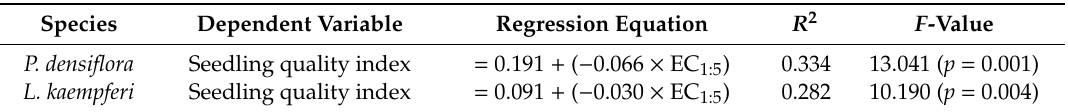
Table 3. Stepwise multiple regression analysis of seedling quality index (SQI) and selected soil parameters (AP, Ca 2 + , Mg 2 + , EC 1:5 , and nematode density) from nonmetric multidimensional scaling